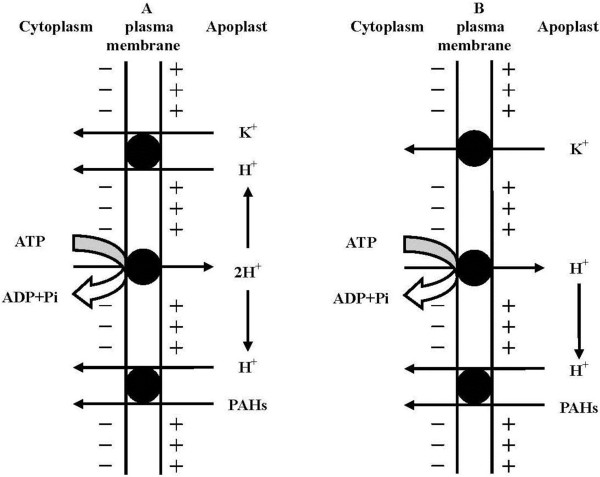
A conceptual model proposed for the coupling of phenanthrene transport into root cells and a potassium influx/proton efflux reaction. A is for the high-affinity potassium transport system (HATS), B is for the low-affinity potassium transport system (LATS). In HATS, the symport of H+/K+ activates proton pump mediated by plasma membrane H+-ATPase, then forming a transmembrane electrochemical proton gradient. The electrochemical proton gradient drives the phenanthrene/proton symport system. In LATS, K+ influx via channels stimulates proton pump, and establishes an electrochemical proton gradient acting as a driving force for H+/phenanthrene symport. Pi, inorganic P. PAHs, polycyclic aromatic hydrocarbons.